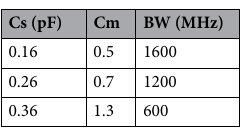
Table 1. Values of Cs and its corresponding Cm and band-width.